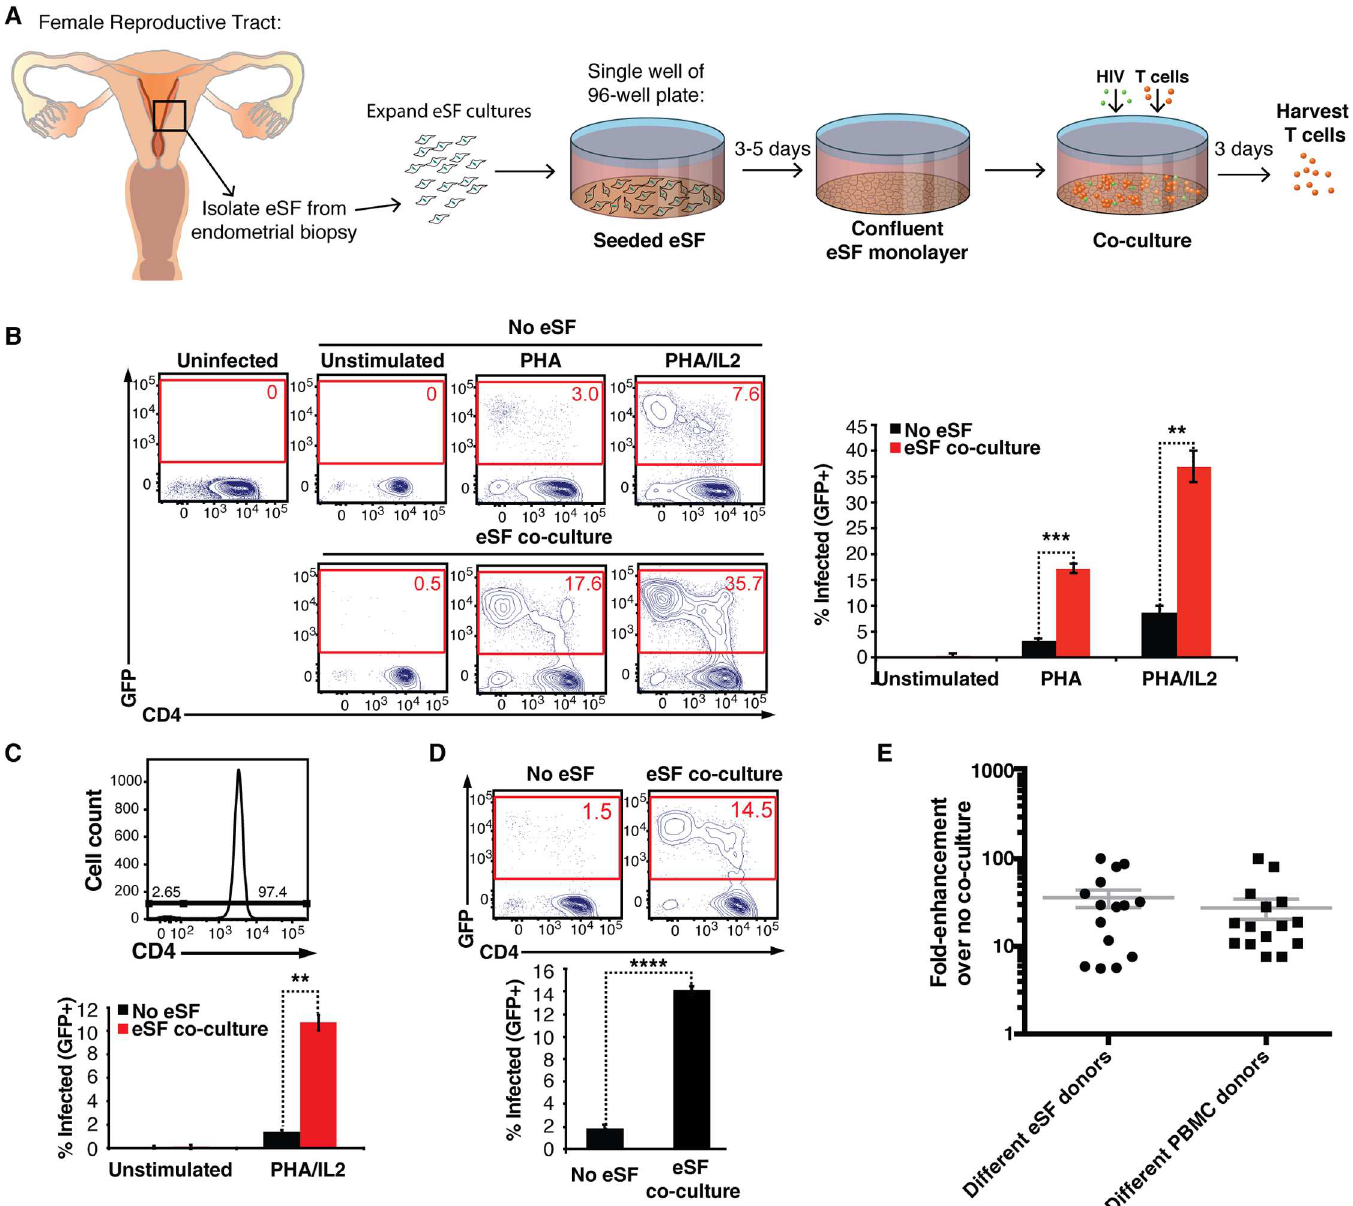
Fig 1. eSF enhance HIV infection of CD4+ T cells. (A) Schematicof infectionof T cells in the absenceor presenceof eSF co-culture. eSF are grown until confluency,at which time PBMCs are added at a ratio of 10 PBMC: 1 eSF. HIV is then added and infection rates are assessed3 d later by flow cytometry. (B) Unstimulated, PHA-activated, or PHA/IL2-activated PBMCs were infected with an HIV reporter virus encoding GFP (NLENG1I, derived from CXCR4-tropic NL4-3) in the absenceor presenceof eSF, and monitored 3 d later for levels of productiveinfection. Left : Representative flow cytometric plots. Right : Results of experimental triplicate measurements. Results are gated on live, singletCD3+CD8-cells. ** p < 0.01, *** p < 0.001(by 2-tailed t test). Representative of data from > 10 experiments each with different eSF donors. (C) Purified CD4+ T cells were infected with NLENG1I in the absenceor presenceof eSF. Top : PBMC- derived CD4+ T cells were isolatedto > 97% purity. Bottom : These cells were left unstimulated or activated with PHA/IL2, infected with NLENG1I in the absenceor presence of eSF, and monitored for infectionlevels 3 d later by flow cytometry. Results are gated on live, singlet CD3+CD8-cells. ** p < 0.01(by 2-tailed t test). Representative of data from 3 experiments each with different eSF donors. (D) CD3/CD28-activated PBMCs were infected with NLENG1I in the absenceor presenceof eSF and monitored 3 d later for infection. Top : Representative flow cytometric plots. Bottom : Results of experimental triplicate measurements. Results are gated on live, singlet CD3+CD8- cells. **** p < 0.0001 (by 2-tailed t test). Representative of data from 3 experiments each with different eSF donors. (E) Fold-enhancement of NLENG1I infectionof PBMCs when comparing infection rates in the presenceversus absenceof eSF. Shown are the results summarizing15 experiments each using a different eSF donor ( left , mean: 36-fold), and 15 experiments each using a different PBMC donor ( right , mean: 28-fold).